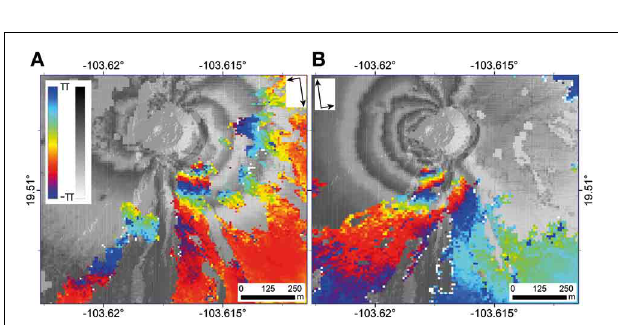
FIGURE 4 | InSAR data prior to and covering the January explosion. The co-explosive deformation in LOS (in color) is shown overlying the pre-explosive inflation fringes (grayscale) in the descending and ascending interferograms ( A and B , respectively). The shaded relief of the summit dome can be seen in the center, not covered by